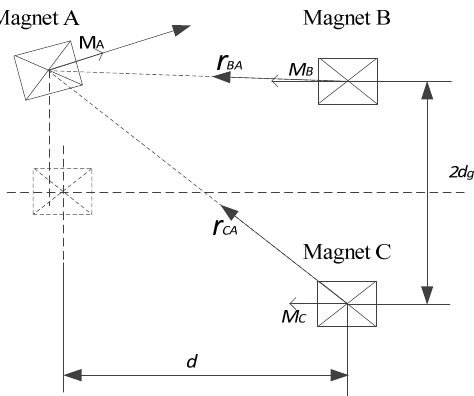
Figure 4. Nonlinear magnetic force model.